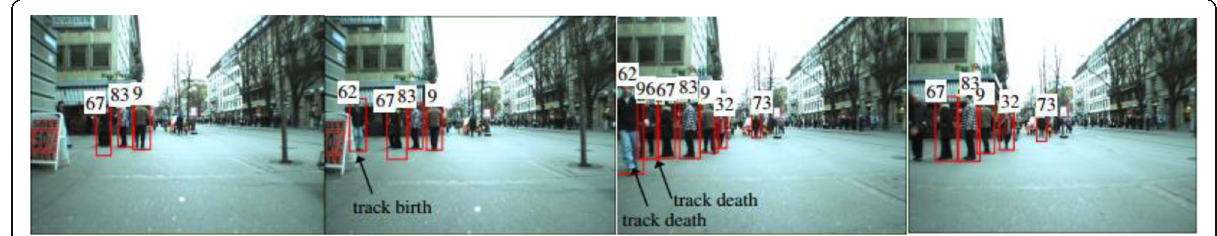
Fig. 9 Illustration of tracking variable number of human objects in an outdoor scene, including estimated track births and deaths